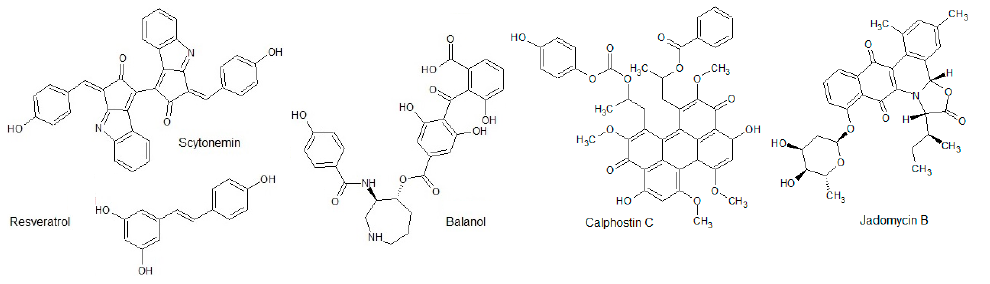
Figure 8. Structures of balanol, scytonemin, resveratrol, calphostin C, and jadomycin B.